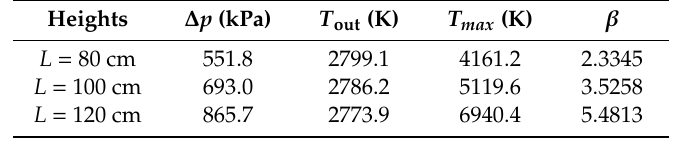
Table 4. Thermal hydraulic characteristics in three PBRs of various core heights.